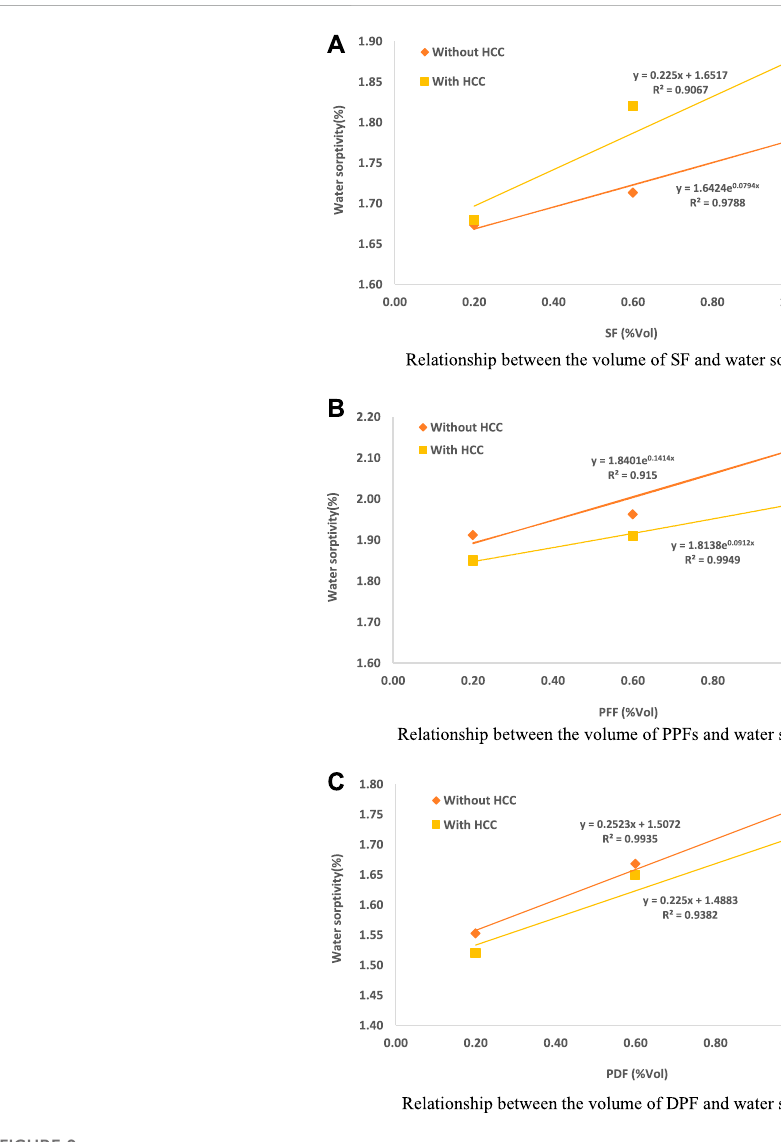
FIGURE 9 Relationship between the volume and water sorptivity of SF, PPF, and DPF. (A) Relationship between the volume and water sorptivity of SF. (B) Relationship between the volume and water sorptivity of PPF. (C) Relationship between the volume and water sorptivity of DPF.